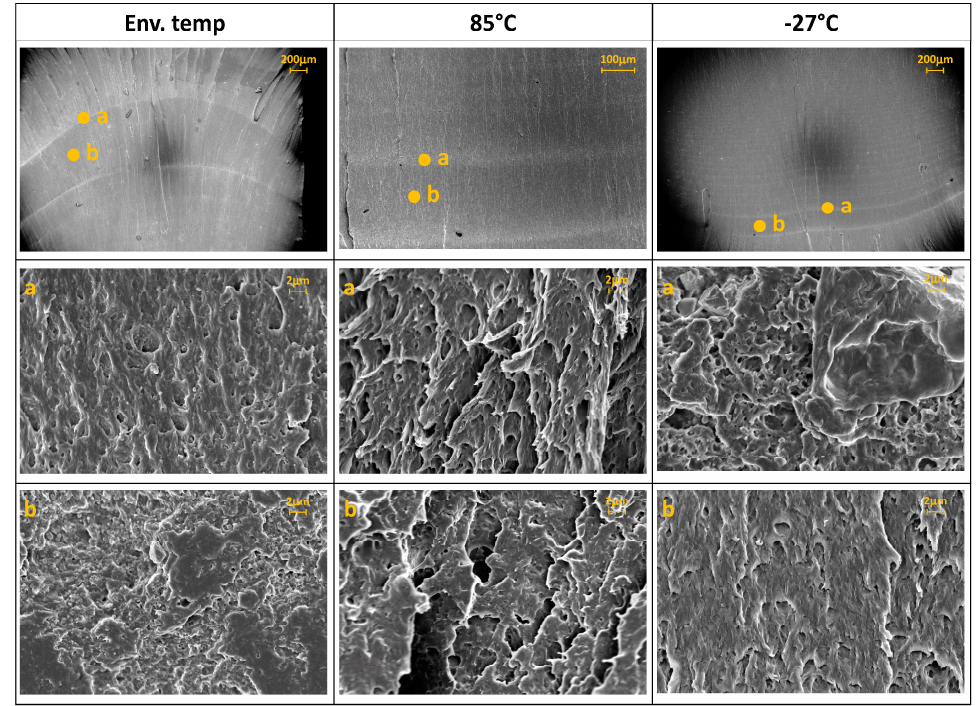
Figure 17. FESEM images of PC-ABS growth bands at different test temperature and magnification of the arrest band ( a ) and between bands ( b ).